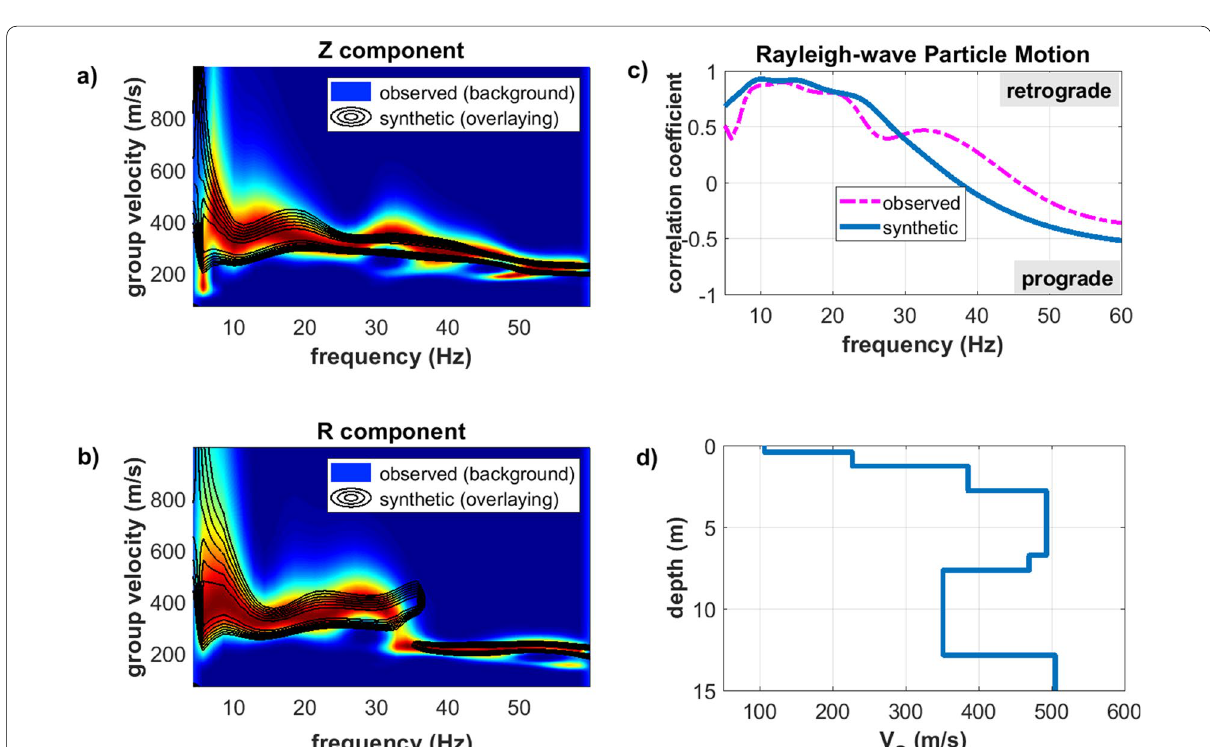
Fig. 4 HS analysis for the San Marco area—P1 site (top of the dune—see map in Fig. 2b): a group-velocity spectra of the field (background colours) and synthetic (overlying black contour lines) for the vertical (Z) component of Rayleigh waves; b group-velocity spectra of the radial (R) component of Rayleigh waves; c field (dashed magenta line) and synthetic (blue line) RPM frequency curves; d V S profile representing the minimum-distance solution of the performed multi-objective inversion (Dal Moro et al. 2019)